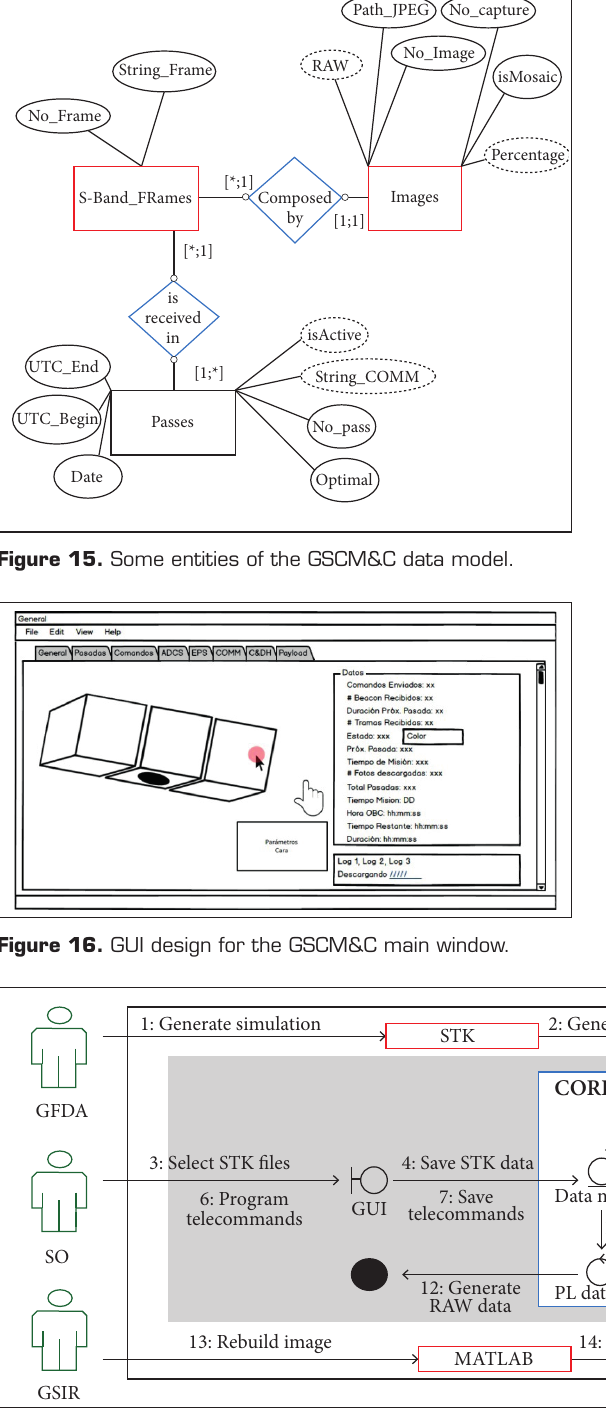
figure 17. GSCM&C MCC operations